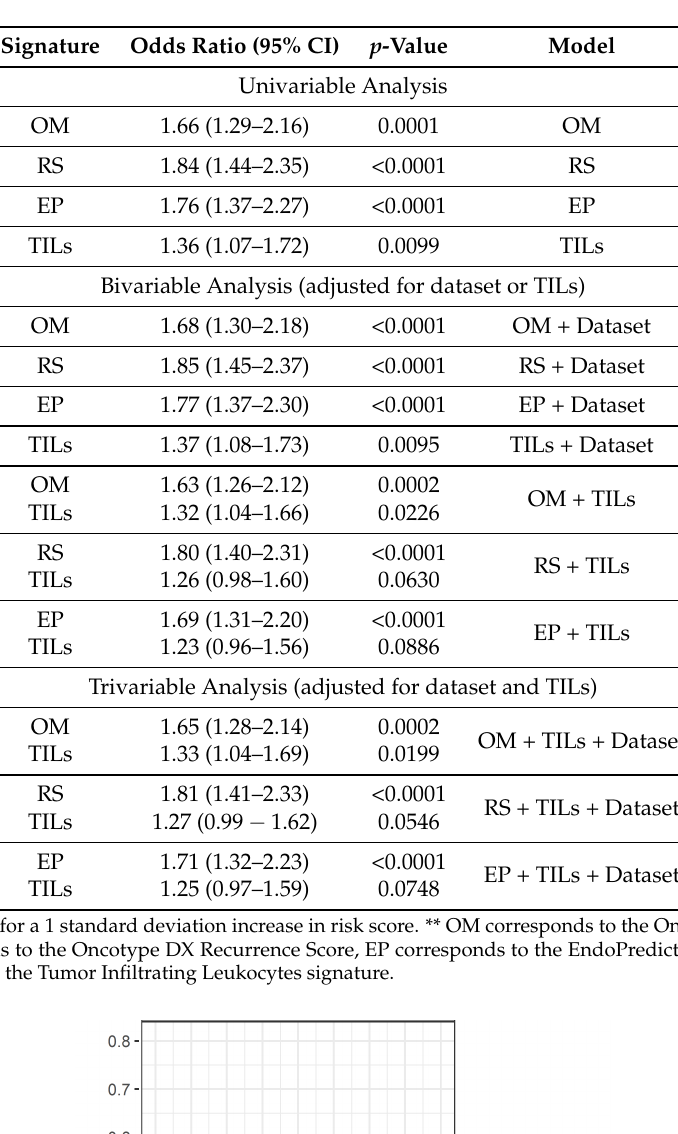
Table 3. Odds ratio (95% confidence intervals) for pCR by risk score * **.